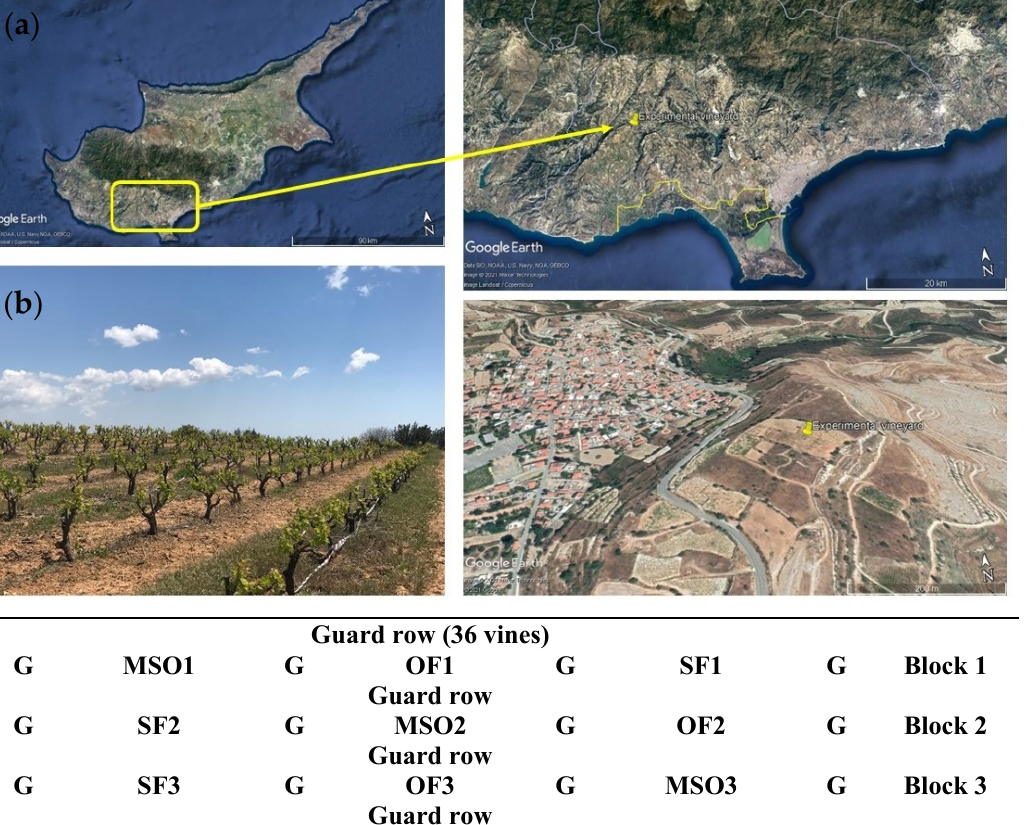
Figure 1. ( a ) Experimental vineyard/study area. ( b ) Experimental design. In each block, the orange (G) represents 3 vine guards (a total of 12), and among them, the 3 treatments (MSO, OF, SF) are placed (8 vines per treatment). Among the blocks, guard rows were established (36 vines).